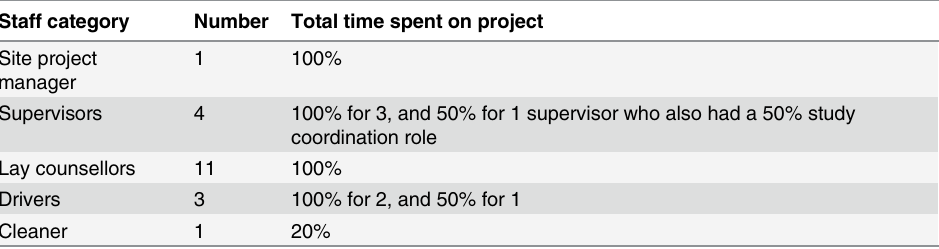
Table 1. Good Start intervention